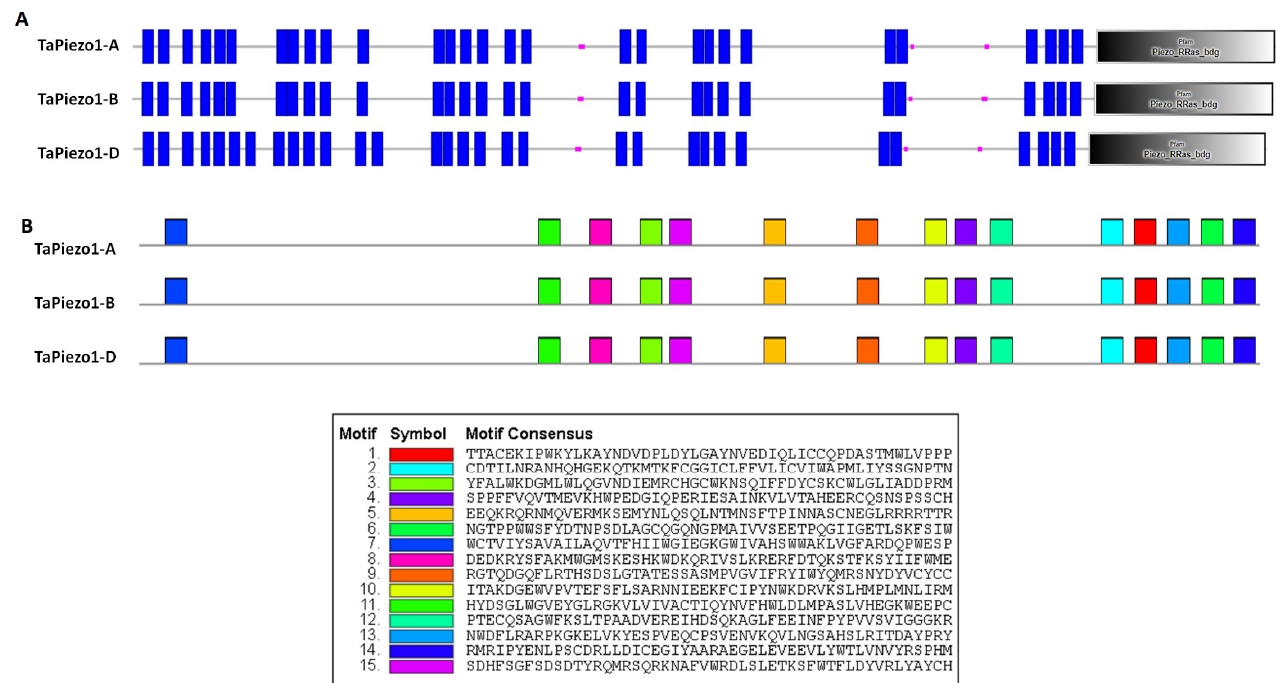
Figure 4. Protein structure analysis of TaPiezo proteins. ( A ) represents the schematic diagram of TaPiezo proteins obtained from the SMART server. ( B ) represents the arrangement of 15 conserved motifs of each TaPiezo protein, represented as colored boxes.